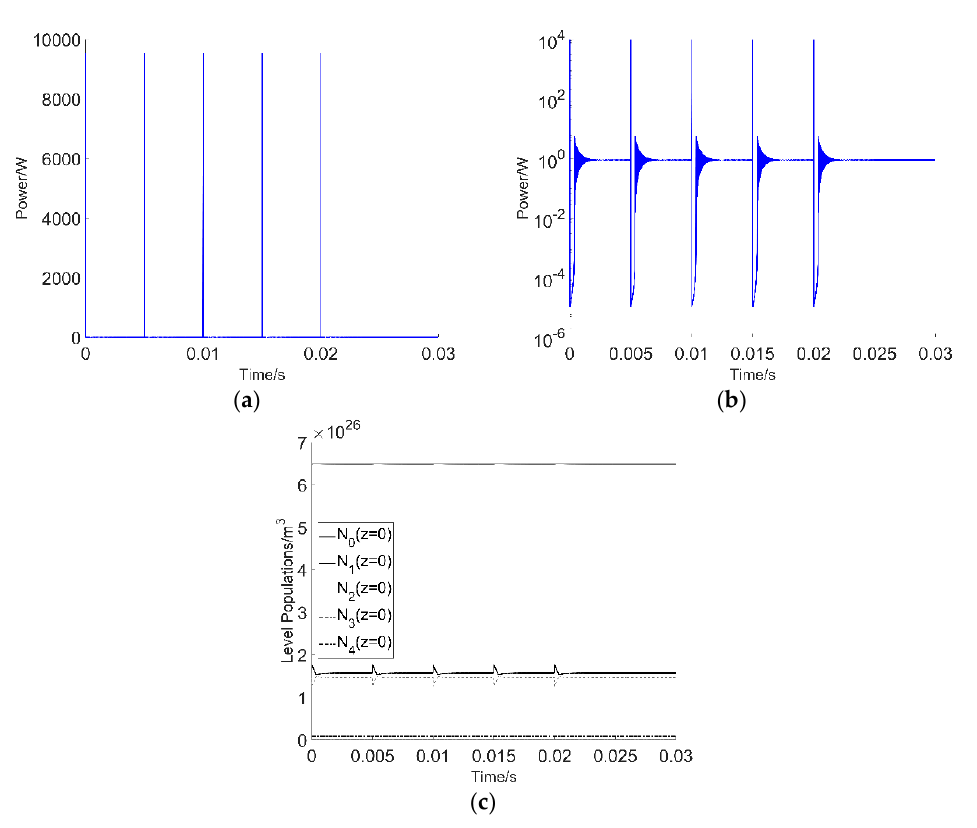
Figure 12. Numerically calculated dependence of the output power and energy level populations on time for 5 pulses at T tr = 200 (ns) with the facet reflectivity for signal wave at z = L switched between 0.04 and 0.2, L = 2 (m) and pump power of 8 (W): ( a ) Output power on linear scale; ( b ) Output power with vertical logarithmic scale; ( c ) energy level populations.